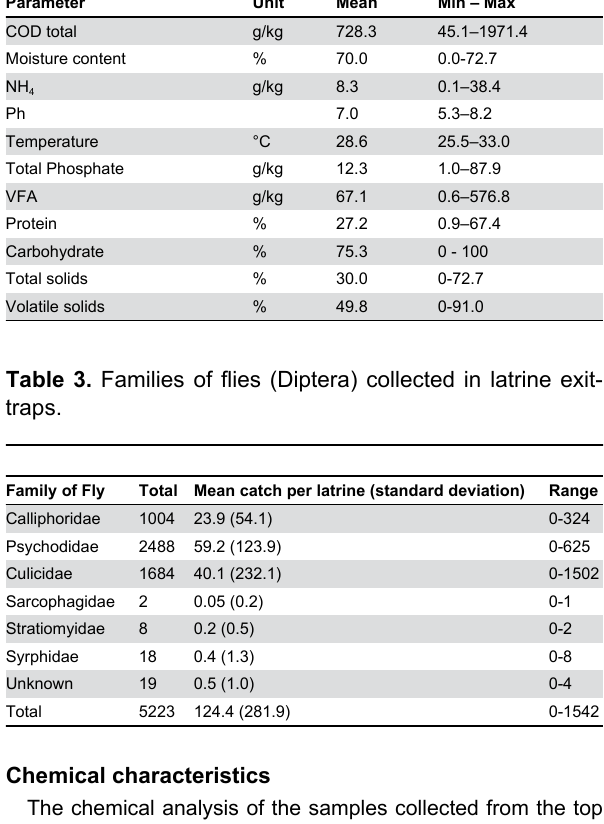
Table 2. Characteristics of latrines contents sampled for flies (n=42), reported as dry weight.